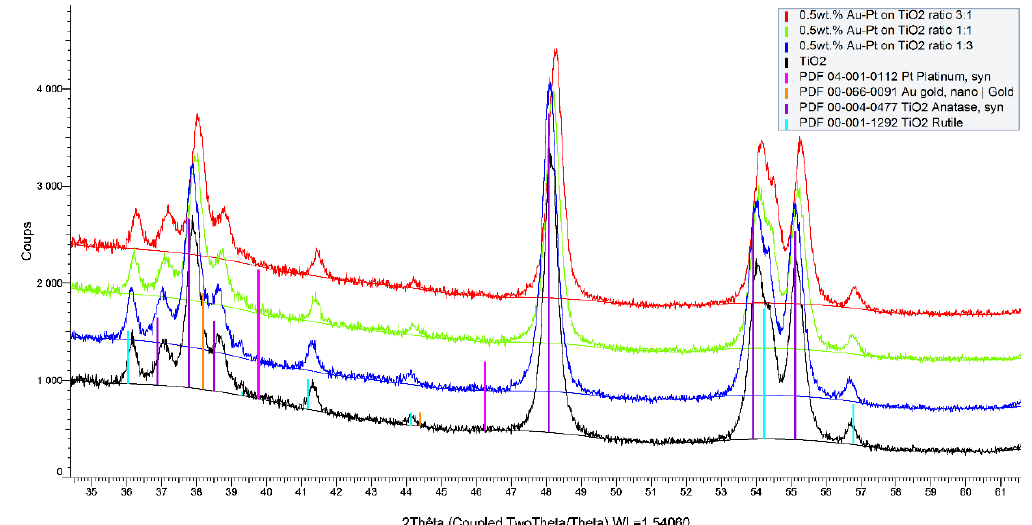
Figure 1. X-ray diffractograms of 0.5 wt.% of Au-Pt/TiO 2 catalysts with Au-Pt molar ratio of 3:1, 1:1, and 1:3.